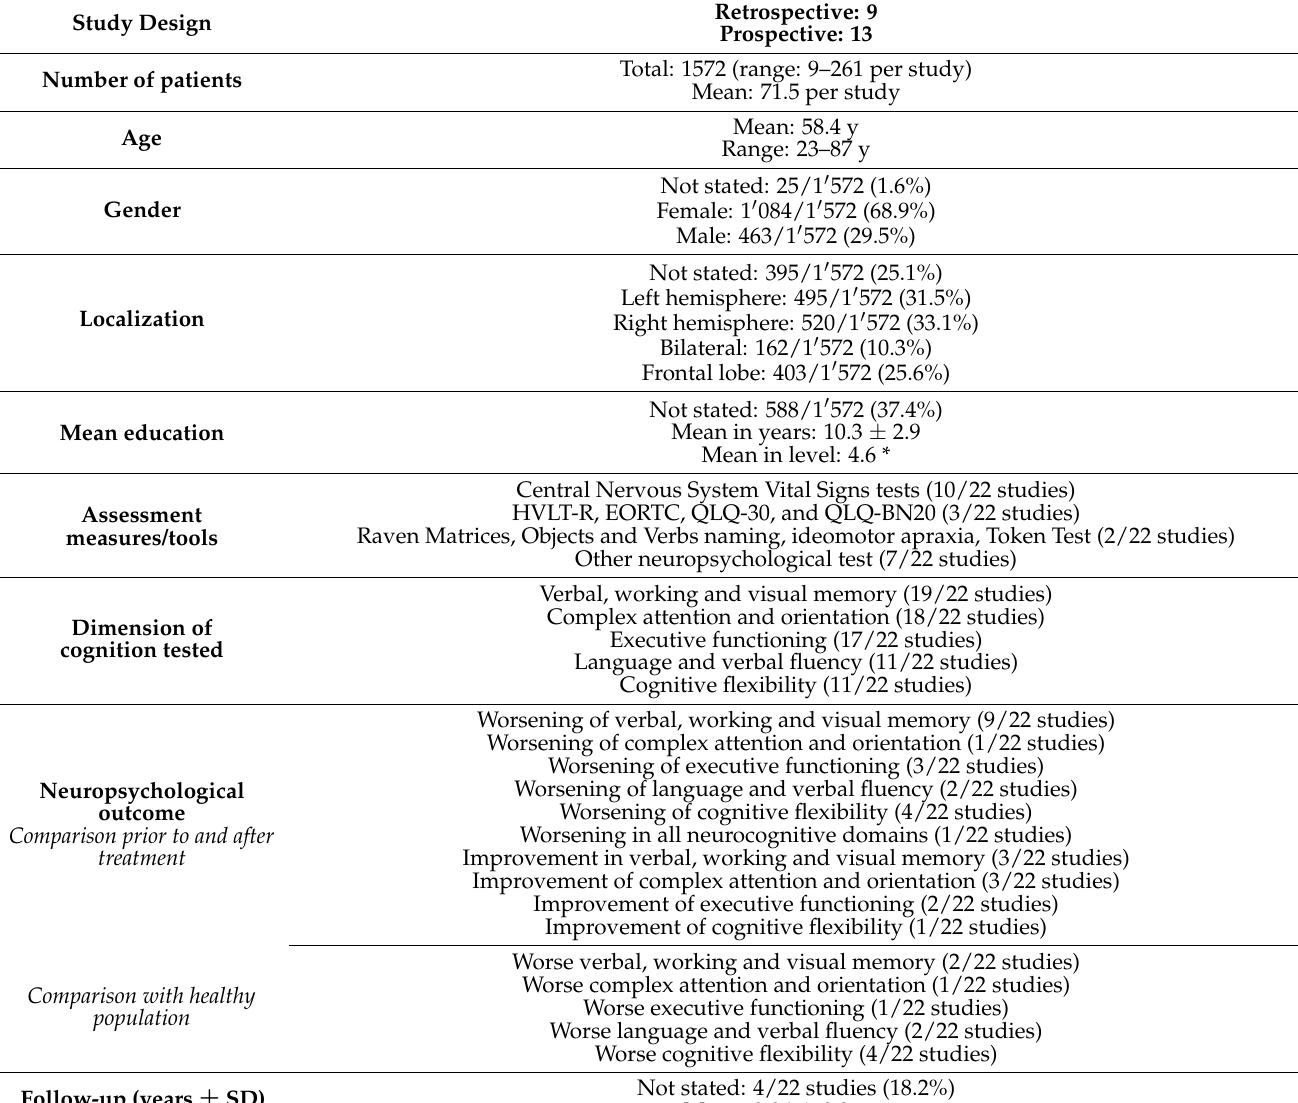
Table 1. Summary of all studies on meningioma and cognition (study and patient characteristics). * according to the Dutch scoring system (Verhage), which consists of an eight-point scale, ranging from unfinished primary education (level 1) to university level (level